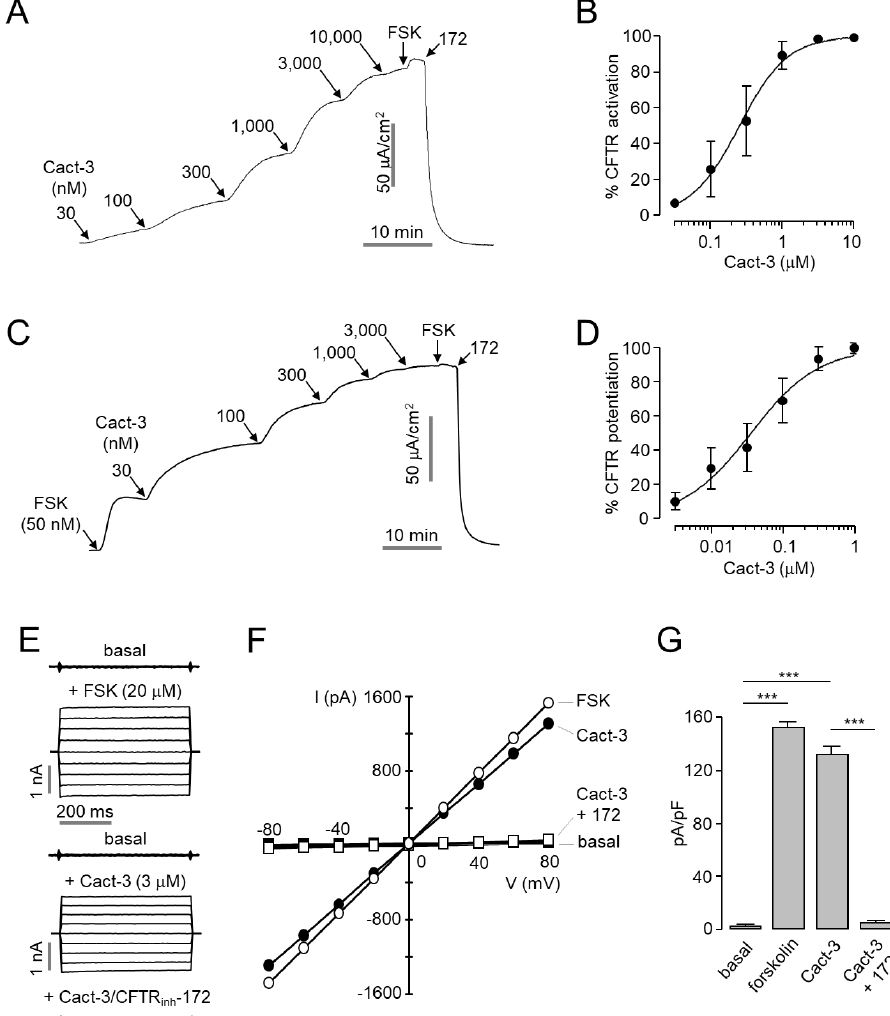
Figure 2. Potent activation of CFTR Cl - channels by Cact-3. ( A ) Apical membrane currents were measured in FRT-CFTR cells. CFTR was activated with the indicated concentrations of Cact-3. ( B ) Summary of CFTR activation (mean ± S.E., n = 3). ( C ) Potentiation of CFTR channel activity by the indicated concentrations of Cact-3. CFTR was weakly activated by 50 nM forskolin, fully activated by 20 μ M forskolin, and inhibited by 10 μ M CFTR inh -172. ( D ) Summary of CFTR potentiation (mean ± S.E., n = 3). ( E ) Whole-cell currents were recorded at a holding potential of 0 mV and pulsed to voltages between ± 80 mV (in steps of 20 mV) in CHO-K1 cells expressing WT-CFTR. CFTR was activated by indicated concentrations of forskolin and Cact- 3 and inhibited by 10 μ M CFTR inh -172. ( F ) Current/voltage(I/V) plot of mean currents at the middle of each voltage pulse. ( G ) Summary of current density at +80 mV (mean ± S.E., n = 3). *** p <